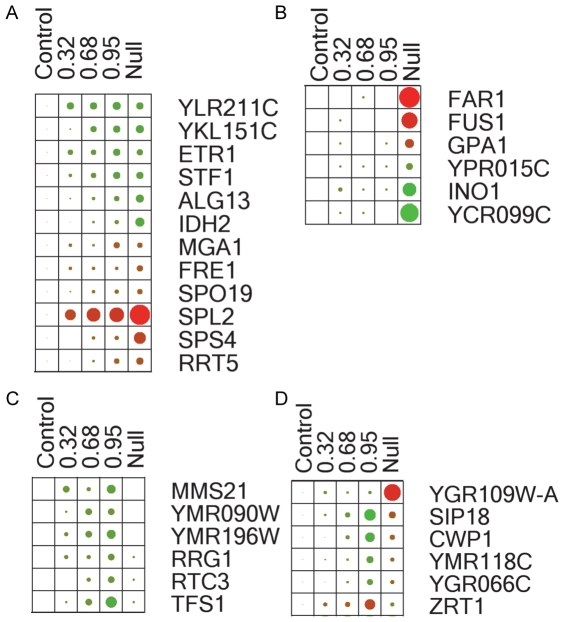
Gene expression heat maps for select genes illustrating unique traits in this study.Four key (non-mutually exclusive) trends in gene expression were observed in this study: catalytically associated genes, false negatives (compared to a knockout), non-catalytically associated genes, and opposites. In the heat map, red indicates underexpression, and green overexpression relative to the control, and the size of the dot is proportional to magnitude of expression. A select sample of genes was used to display the four trends. a. Catalytically associated genes have expression that changes (either up or down compared to control) as a function of gcn5-F221A. The threshold for response varies for each of these genes. b. 129 non-catalytically associated genes (changed in gcn5Δ, but not graded by gcn5-F221A) were identified, suggesting these targets are not impacted by Gcn5p acetylation, but perhaps by another indirect effect of Gcn5p such as protein complex association. c. 36 false negative genes were identified, in which expression is graded by the dominant mutant, but are unchanged in the knockout strain. These genomic loci are most likely directly acetylated preferentially by Gcn5p along with other compensatory HATs. d. An additional set of 44 genes demonstrate an opposite effect in the presence of the dominant mutant compared to the gcn5Δ.